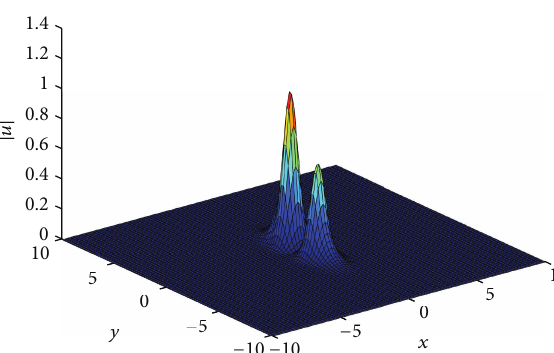
Figure 5: Soliton solution |𝜙| 2 at 𝑡 = 0 .